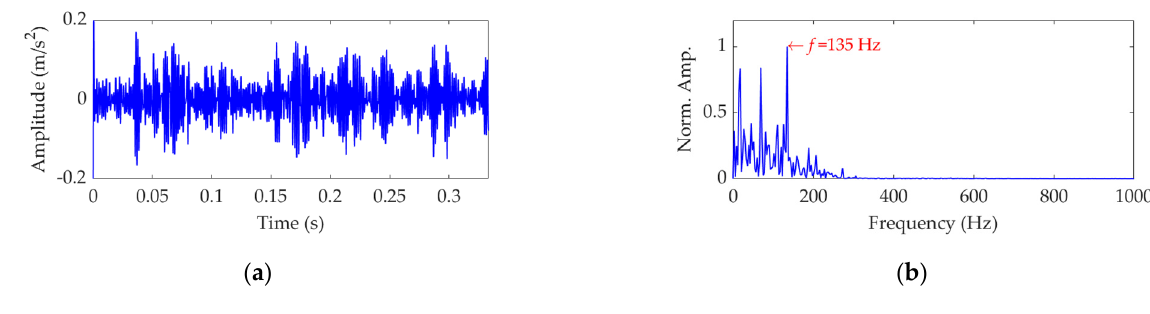
Figure 27. The target mode obtained by VMD: ( a ) time − domain waveform and ( b ) SES.